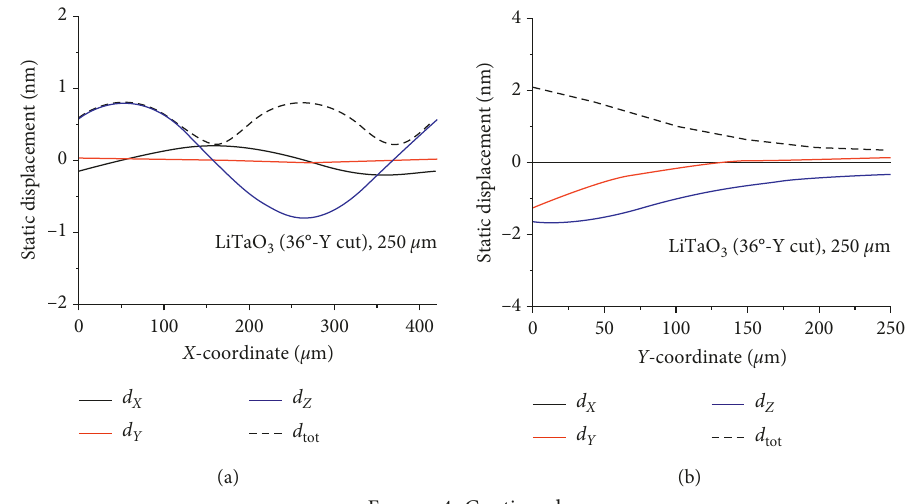
Figure 3: Static displacement distribution at a crystal thickness of 50 μ m measured in μ m. The d displacements measured (a) at the middle of the crystal along X -axis direction and (b) along thickness. Total static displacement measured (c) in the middle of the crystal and (d) along the